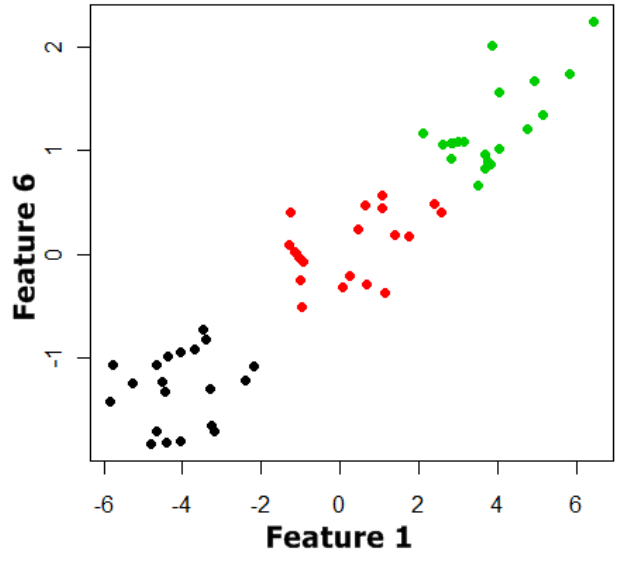
Figure 8. Two dimensional representation of the classification